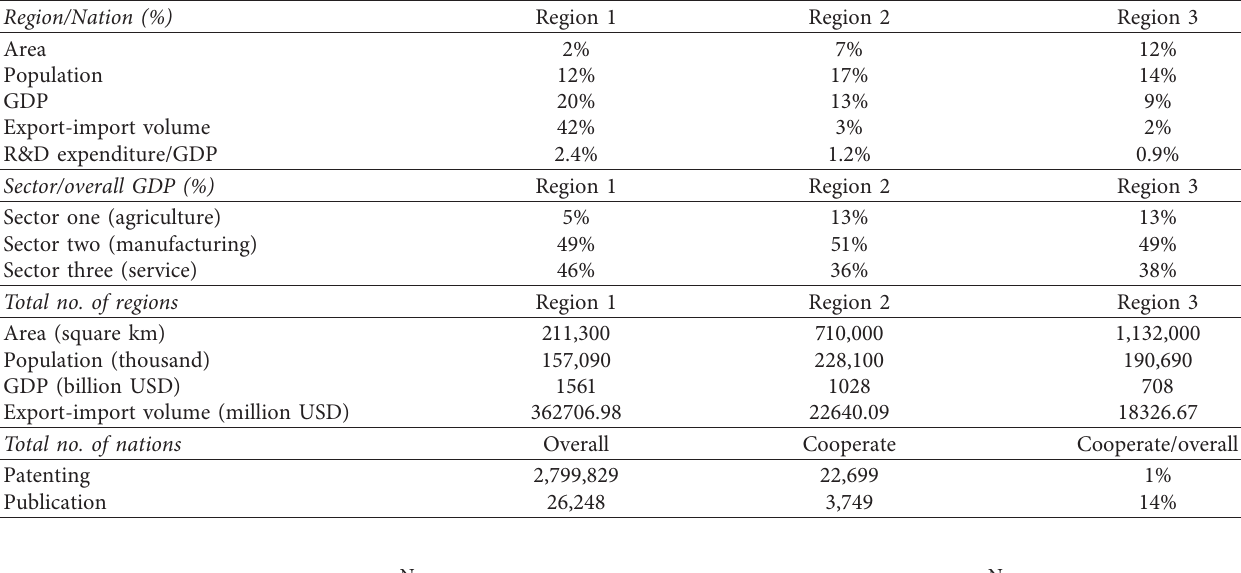
Table 2: Context of the research